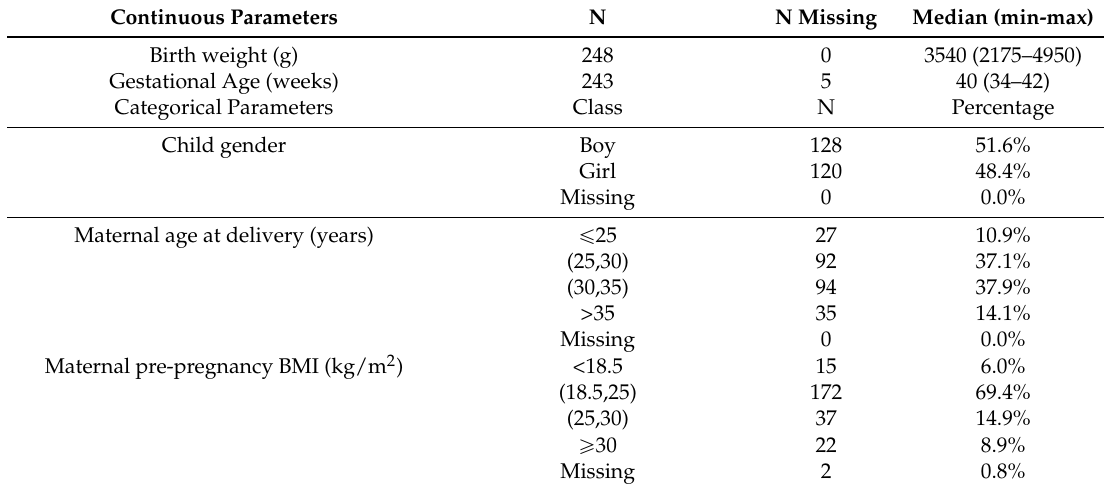
Table 1. Characteristics of newborns and their mothers among 248